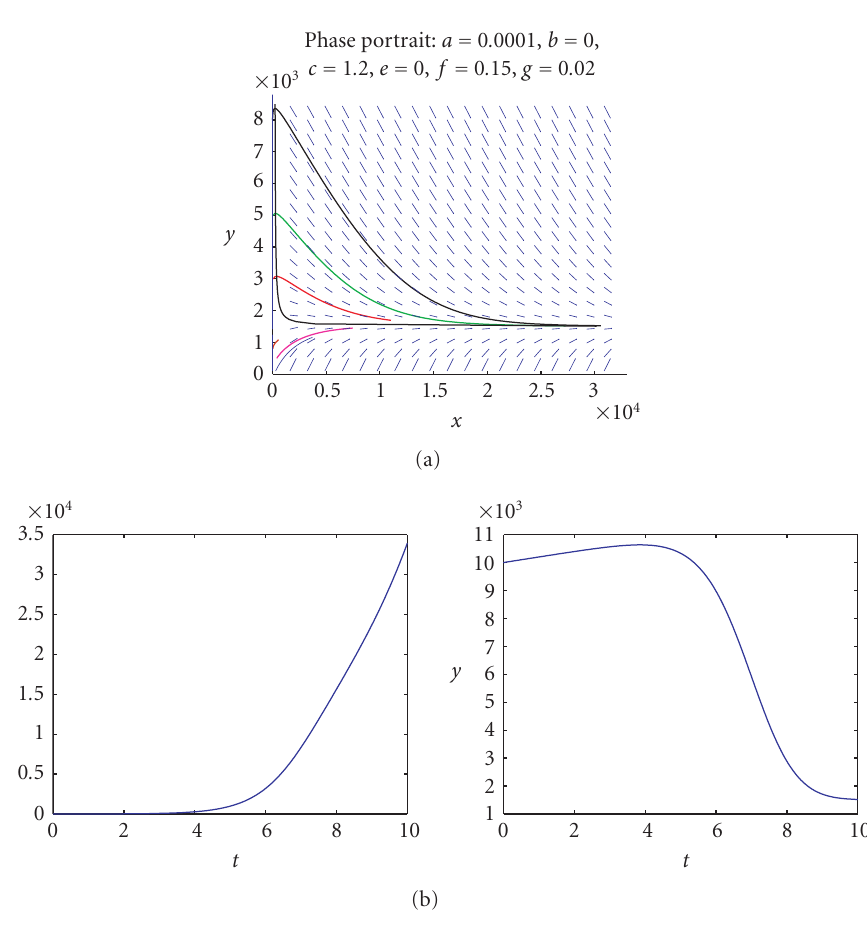
Figure 3.1. (a) Phase plot showing the flow field and the asymptotic behavior of the dynamical system, c > 1. Trajectories starting from di ff erent initial conditions are shown in color. The solid black line is the nullcline axy − f x − gy = 0. Notice that the terrorist population increases constantly while the S population reaches steady state given by y = f/a = 1500. (b) The time evolution of the dynamical system starting from x (0) = 2, y (0) = 10,000 shows the run-away terrorist population; the susceptible population reduces to its asymptotic value of